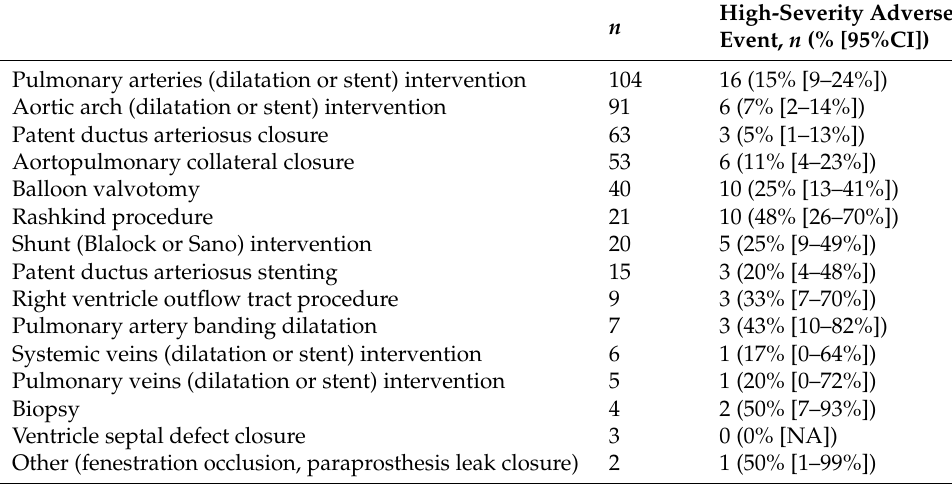
Table 5. Intervention in catheterization laboratory and high-severity adverse events.